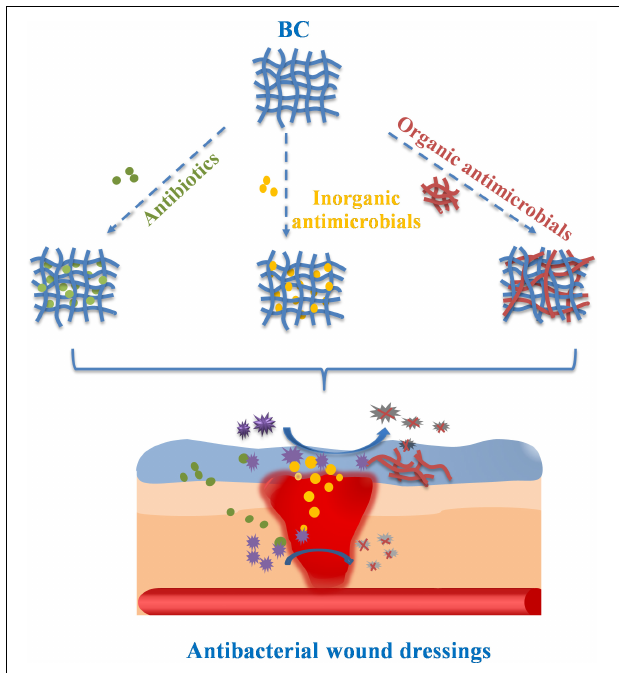
FIGURE 2 | The preparation and slow release behavior of BC-based antibacterial wound